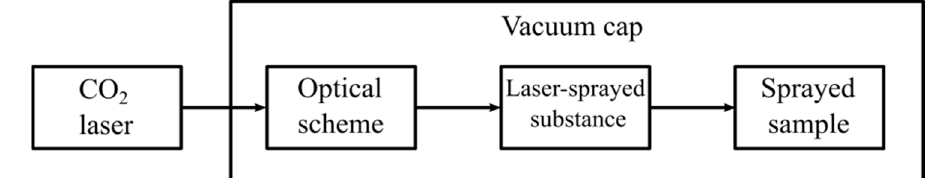
Figure 1. Principle scheme of the laser-deposition technique.